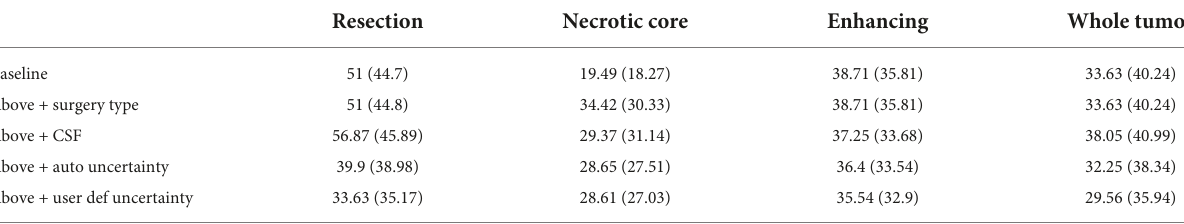
TABLE 1C A comparison of Hausdorff distance (mm) for three glioblastoma multiforme (GBM) tissues and for the entire tumor segmented as one